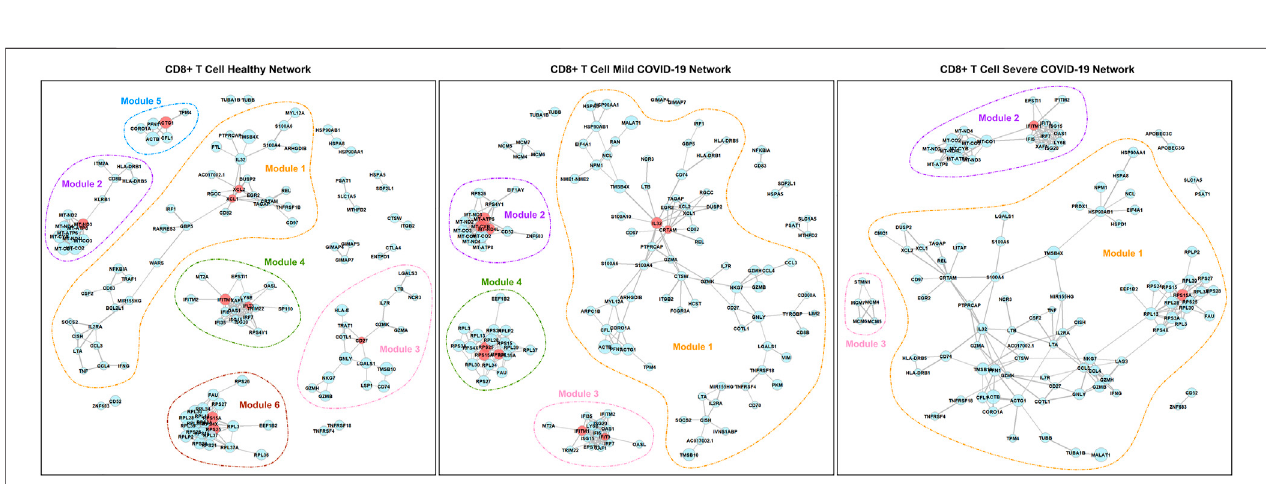
FIGURE 5 | PIDC networks for CD8 + T cells. Node size and edge width represent the average expression level of the gene and the con fi dence of connectivity between a pair of genes in the network, separately. Red nodes are hub genes in the corresponding